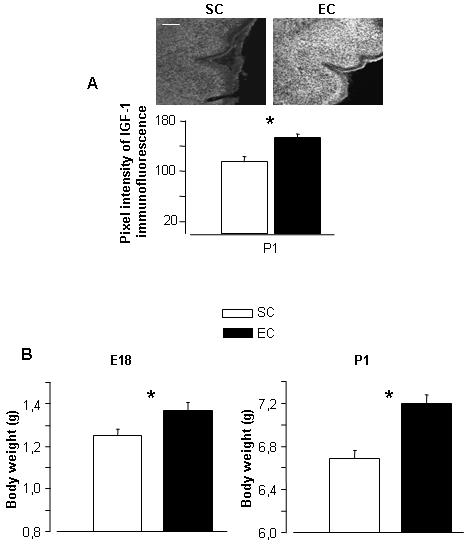
(A) Increased IGF-I levels in the cerebellum of EC rats.Coronal sections through the cerebellum: IGF-I immunoreactivity is low in cerebellar cells of SC rats, while the cerebellar cells of EC rats show a strong IGF-I staining. Scale bar: 50 µm. Graph: quantitative analysis of the pixel intensity of IGF-I immunofluorescence reactivity showed higher levels in the cerebellum of EC (black) compared with SC (grey) rats at P1 (Mann-Whitney rank sum test, p<0.05). The bars indicate s.e.m. (B) Prenatal enrichment increases body weight. The weight of EC fetuses was 10% greater at E18 (n = 19 for EC and n = 15 for SC), and 8% greater at P1 (n = 64 for EC and n = 49 for SC). Two ways ANOVA of rat weights for different environmental conditions and ages showed a significant effect of age (p<0.001) and environmental housing condition (p<0.001). Mann-Whitney rank sum test with Bonferroni correction revealed a significant increase in EC animals body weight compared with SC rats at both E18 and P1 (p<0.001 in both cases).